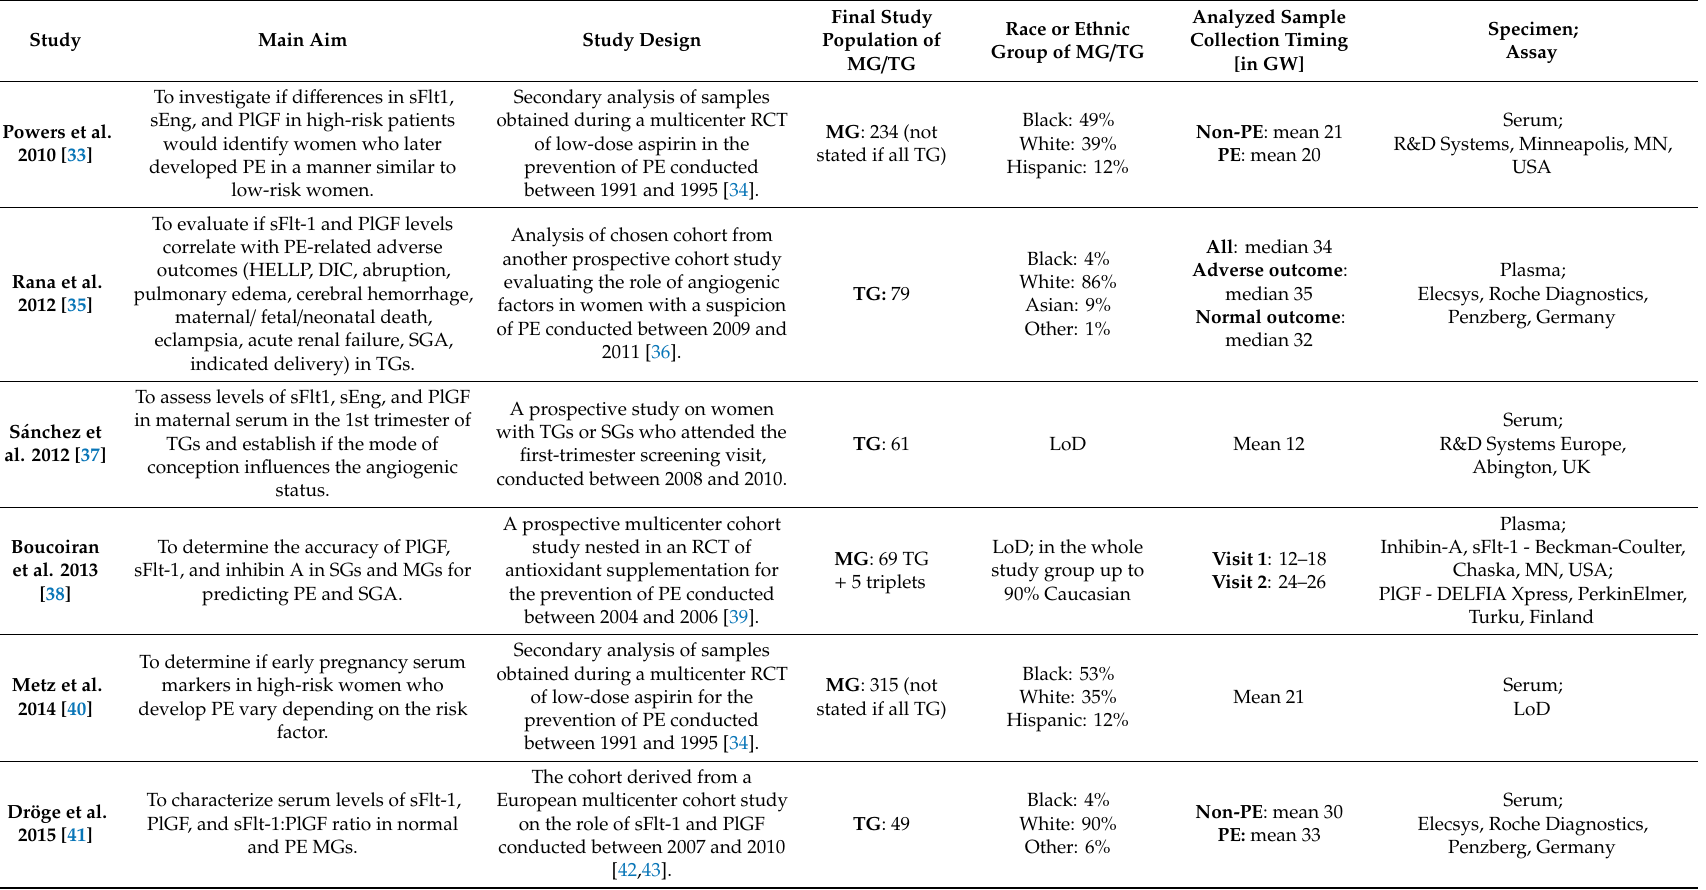
Table 2. Basic characteristics of included